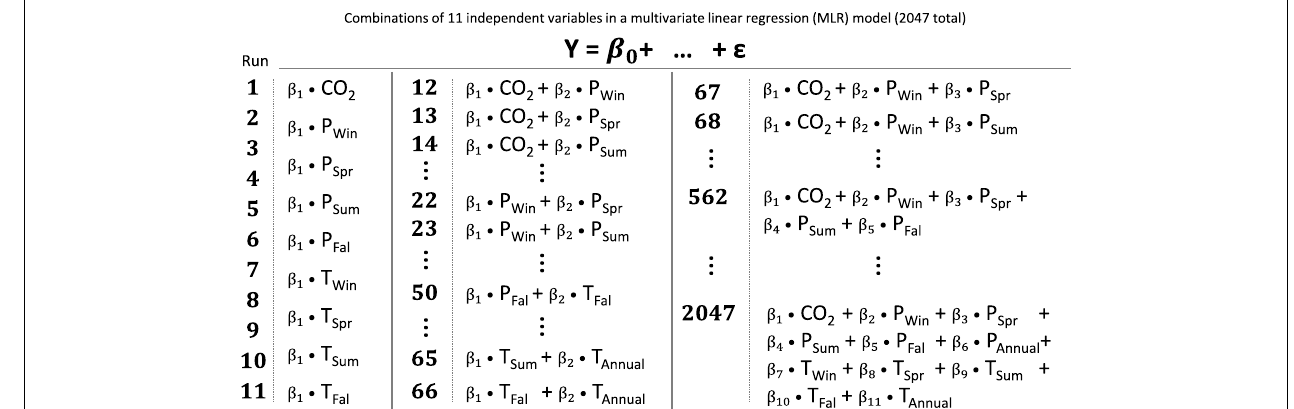
FIGURE 3 | Schematic of how variables were sampled for the MLR models of Approach 2 in Section 2.5.